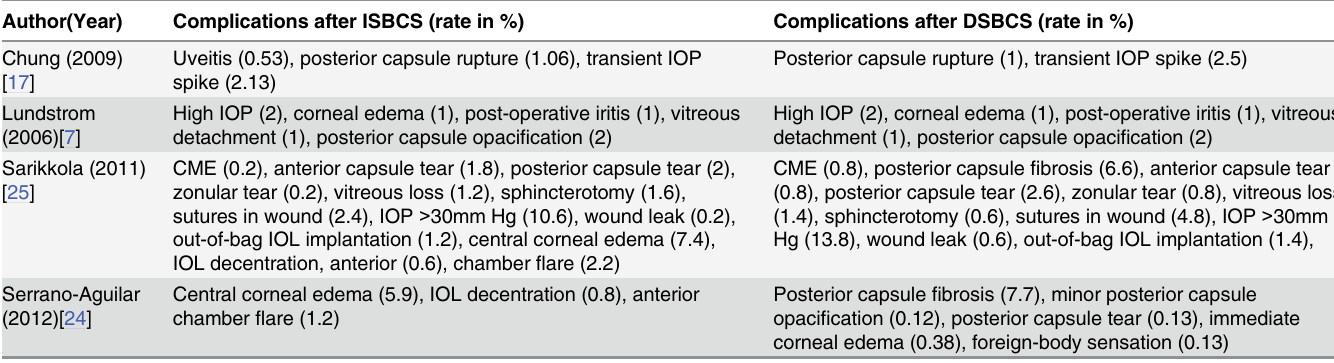
Forest plots were generated. Due to evidence of heterogeneity, a random-effect model was computed. Funnel plot was used to assess the risk of publication bias. Funnel plots for each sub-group, TTO, EQ5D, HUI3, VF-7, Catquest questionnaire, and VF-14 were not considered since just one study reported utility score by TTO, EQ5D, and HUI3 and two studies reported utility score by VF-14, VF-14, and Catquest Questionnaire. Table 4. List of Complications Reported in Included